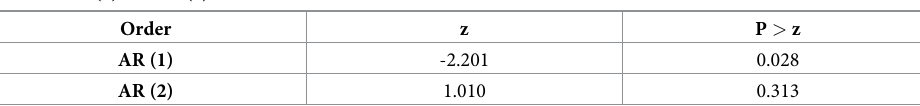
Table 6. AR(1) and AR(2)